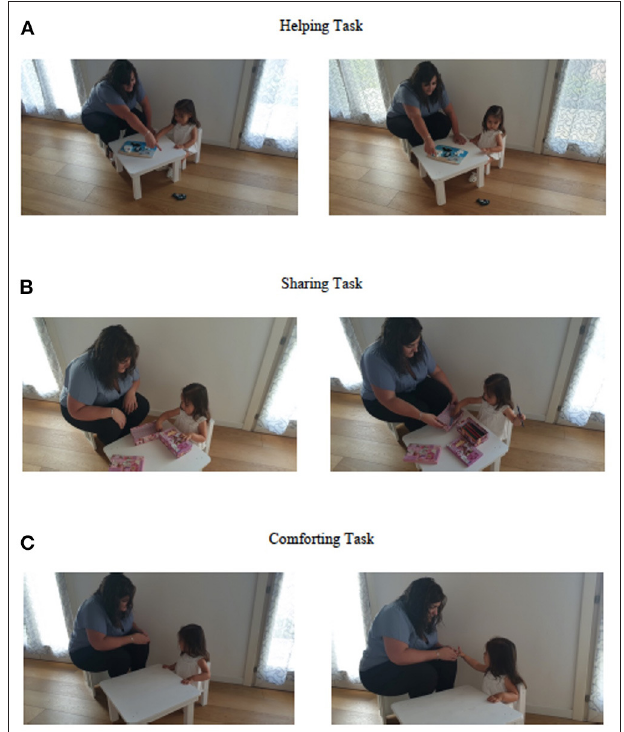
FIGURE 1 | Illustrations of the Italian prosocial task battery (PBT-I). (A) Helping task. (B) Sharing task. (C) Comforting